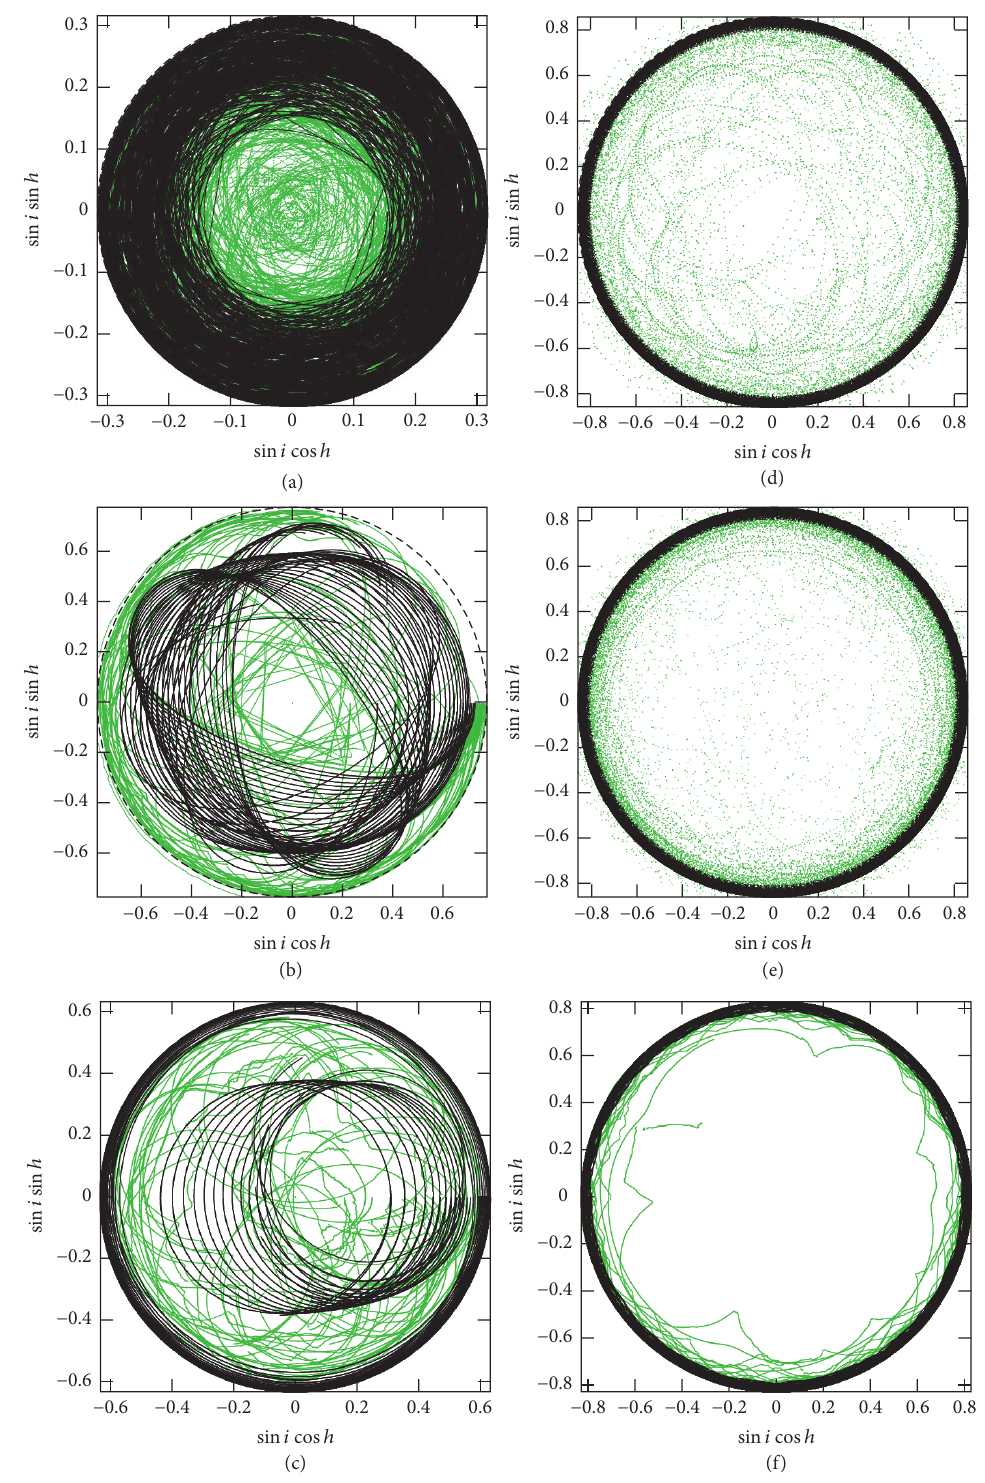
Figure 6: Plots of the perturbed body’s ( sin 𝑖 cos ℎ, sin 𝑖 sin ℎ) values obtained from the direct numerical integration whose parameters are listed in Table 1. The black dashed circles represent the theoretical maximum sin 𝑖 value (which is the same as 𝑒 max ). Meanings of the black dots and the green dots remain the same as in Figure